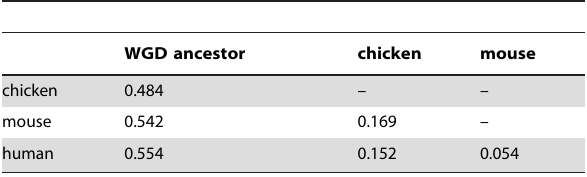
Table 2. Relative DCJ distance among the WGD ancestor, chicken, mouse and